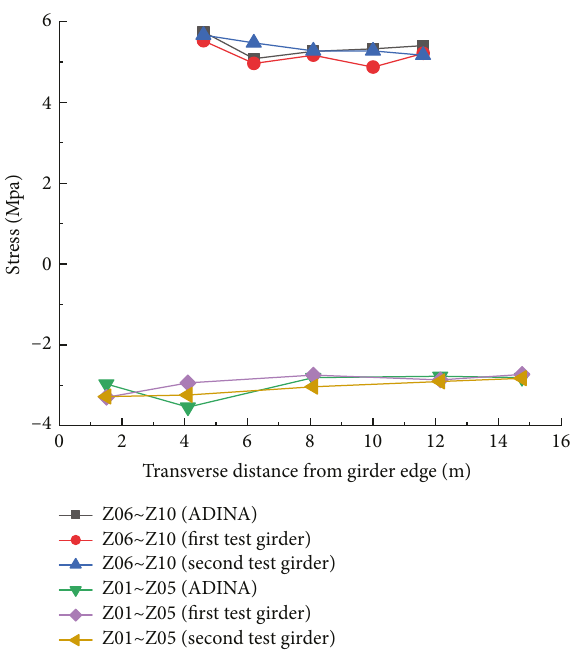
Figure 15: Stress increment of the mid-span section.